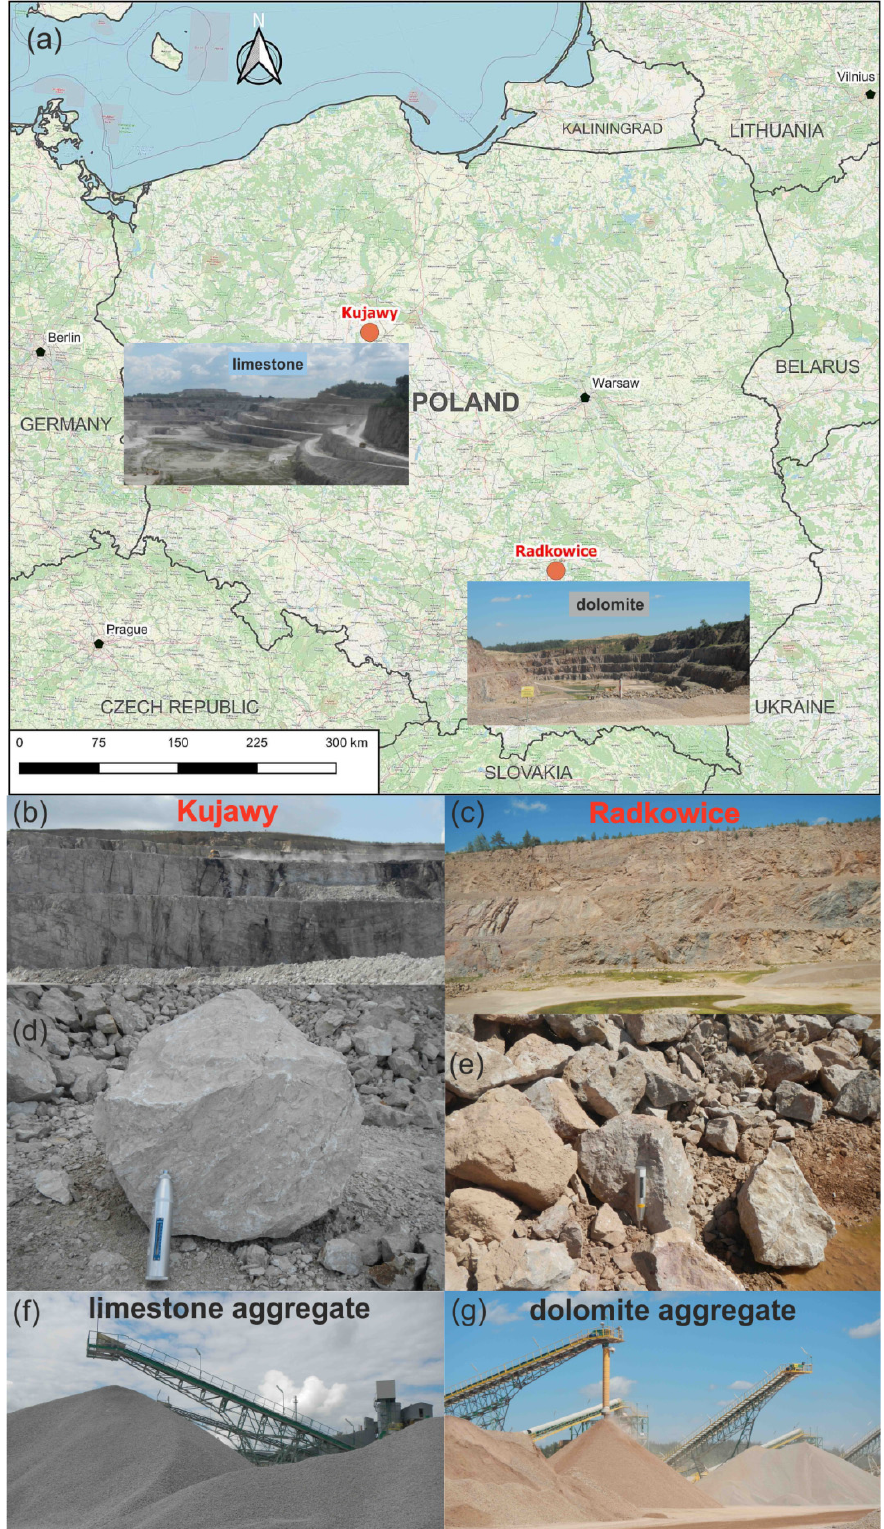
Figure 2. Radkowice dolomite quarry and Kujawy limestone quarry: location and general view of Kujawy quarry and Radkowice quarry ( a ); exploitation wall in Kujawy quarry ( b ) and Radkowice quarry ( c ); stone blocks in Kujawy quarry ( d ) and Radkowice quarry ( e ); aggregate heaps in Kujawy quarry ( f ) and Radkowice quarry ( g ).